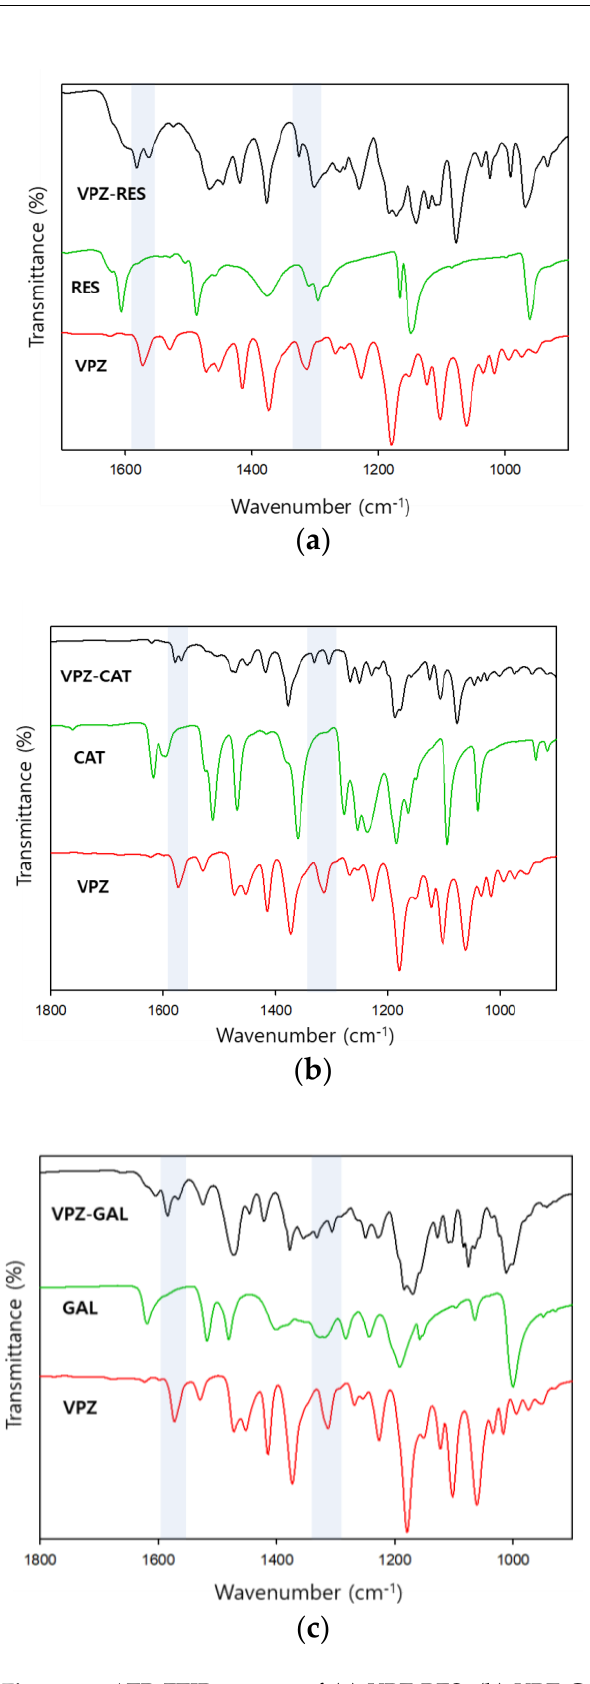
Figure 5. ATR-FTIR spectra of ( a ) VPZ-RES, ( b ) VPZ-CAT, ( c ) VPZ-GAL, and their respective components in the region of 1800–900 cm − 1.